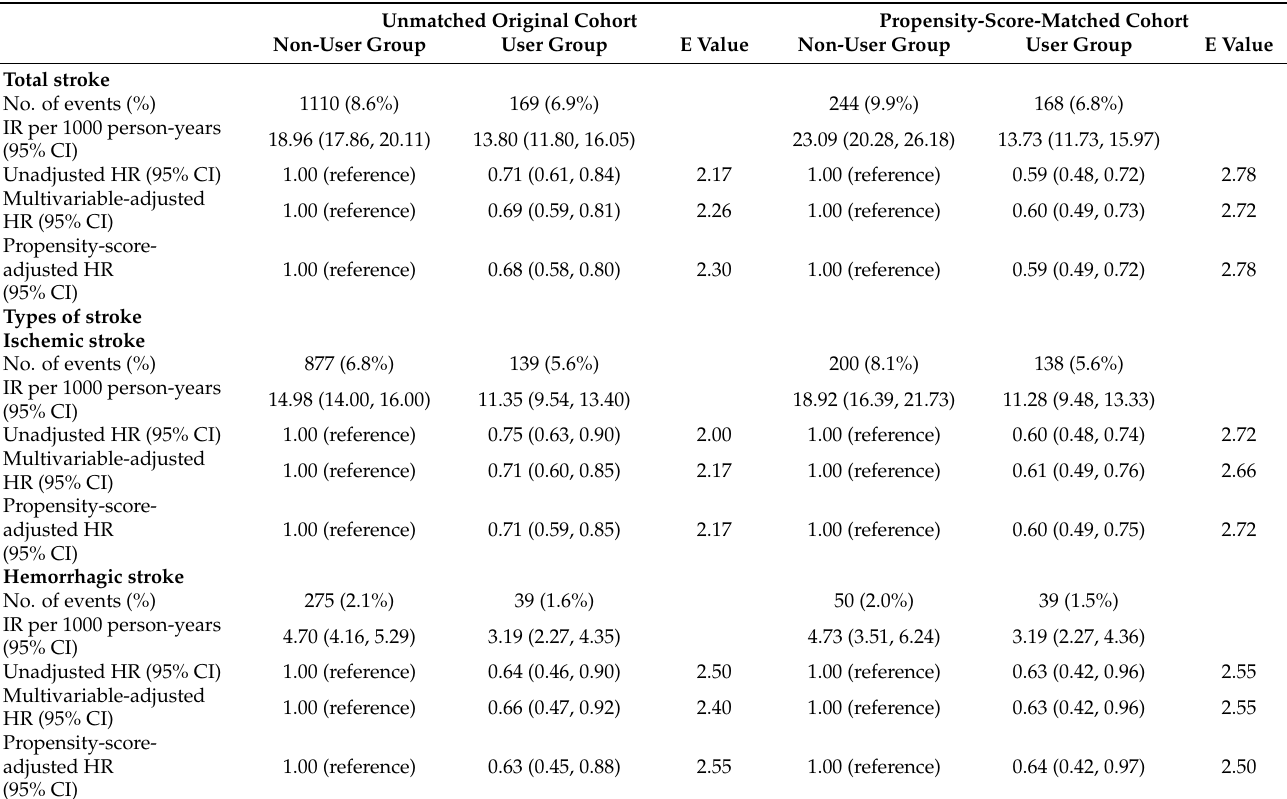
Table 2. Associations between the use of spironolactone and the risk of outcome events. Unmatched Original